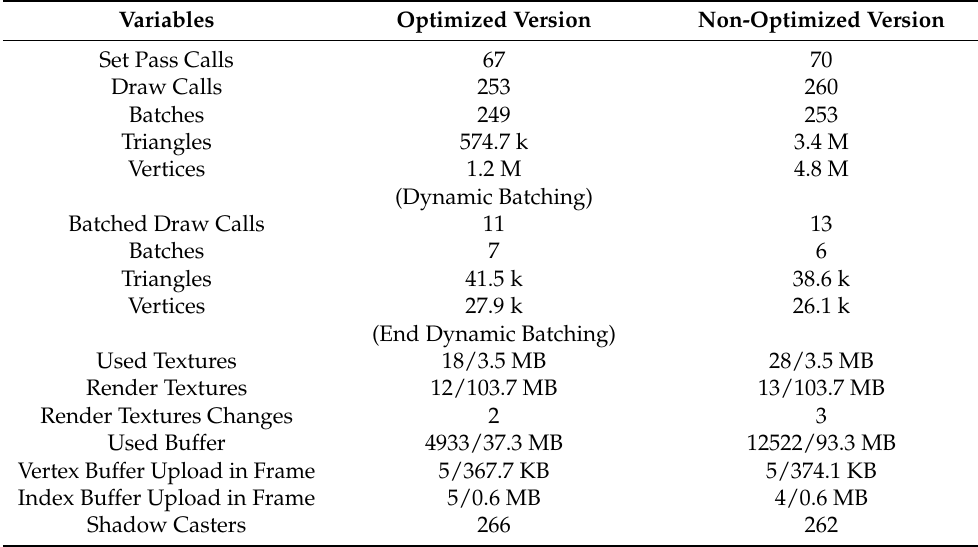
Table 5. Rendering data for a frame with approximately 60 FPS in the CPU usage